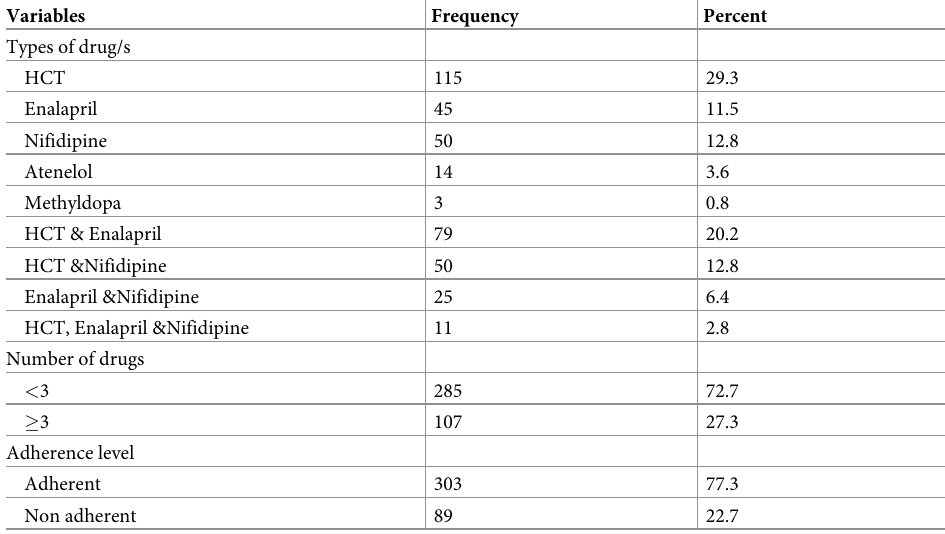
Table 2. Anti-hypertensive drugs and level of adherence for medications (n = 392).